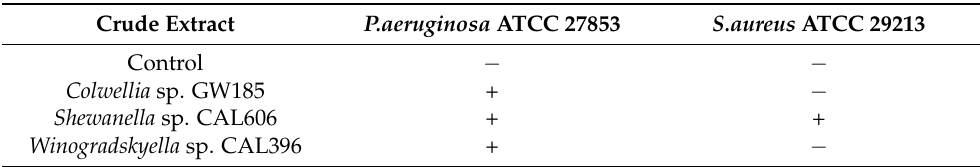
Table 4. P. aeruginosa and S. aureus adhesion to polystyrene in absence (Control) or pre-coated surfaces with crude extract (400 µg/mL) from Colwellia sp. GW185, Shewanella sp. CAL606 and Winogradskyella sp. CAL396 after 18 h treatment.